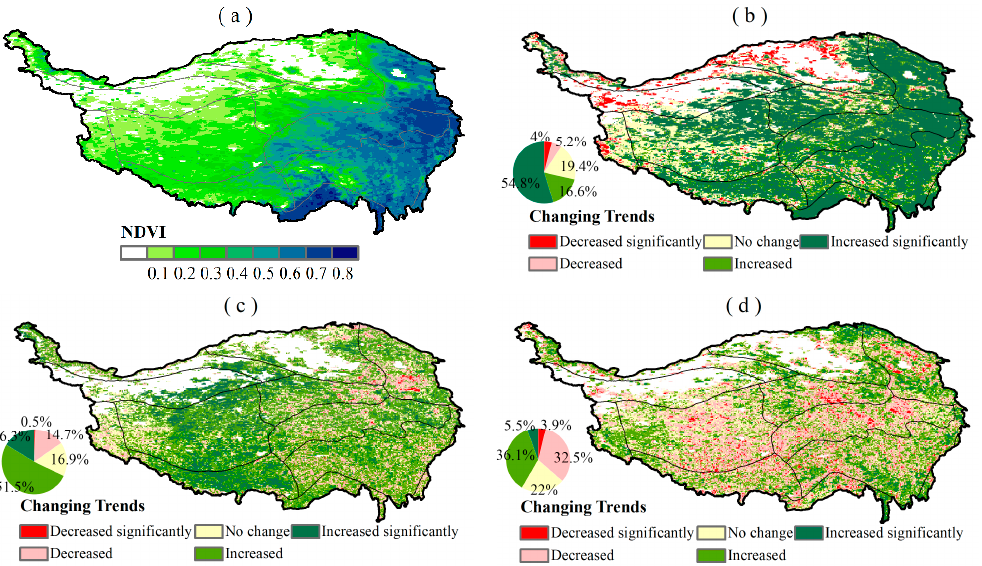
Figure 4. Spatial distribution of annual mean AVHRR NDVI from 1982 to 2019 ( a ); spatial change trend of AVHRR NDVI from 1982 to 2019 ( b ), from 1982 to 2000 ( c ), and from 2001 to 2019 ( d ). Before 2000, the NDVI of the QTP mainly experienced an increasing trend (67.8%), and the area with a significant increase accounted for 16.3% and was mainly distributed in the central QTP (H1C2, H1D1, H2C2). The decreasing trend of the NDVI was mainly distributed in the south of H2C1 of the QTP (14.7%) (Figure 4c). However, the NDVI trend of the QTP after 2000 underwent great changes compared with prior to 2000. The NDVI trend in more regions of the QTP showed a downward trend (decrease of 32.5%; signifi- cant decrease of 9%) after 2000 and was mainly distributed in the H1B1, H1C2, H2C1, H2C2, H2AB1, and H3 regions of the QTP. The increasing trend of the NDVI was mainly distributed in the north of the QTP and the south of H2AB1 (increase of 36.1%; significant increase of 5.5%) (Figure 4d). 3.2. Relationships between Vegetation and Climatic Factors in Different QTP Climate Zones From 1982 to 2019, the NDVI of the QTP was mainly positively correlated with the temperature, accounting for 83.1% of the total area, and 43.3% of the total area was signif- icantly positively correlated and mainly distributed in the eastern, central, and southern regions (H2C1, H1B1, H1C1, H2AB1, H3, and H1C2) of the QTP. The areas with a negative correlation between the NDVI and the temperature were mainly distributed in the arid region, accounting for 15.2%, and the significant negative correlation only accounted for 1.8% (Figure 5a). The NDVI was mainly positively correlated with precipitation, but its spatial distribution differed from that of the temperature. About 71.7% of the NDVI was positively correlated with precipitation, of which 19.6% was significantly positively cor- related and mainly distributed in H1C2, H2C2, H1C1, H1B1, H2C1, and H2D1. The nega- tive correlation between the NDVI and precipitation was mainly distributed in H3 and H2AB1, accounting for 26.3% (Figure 5b).